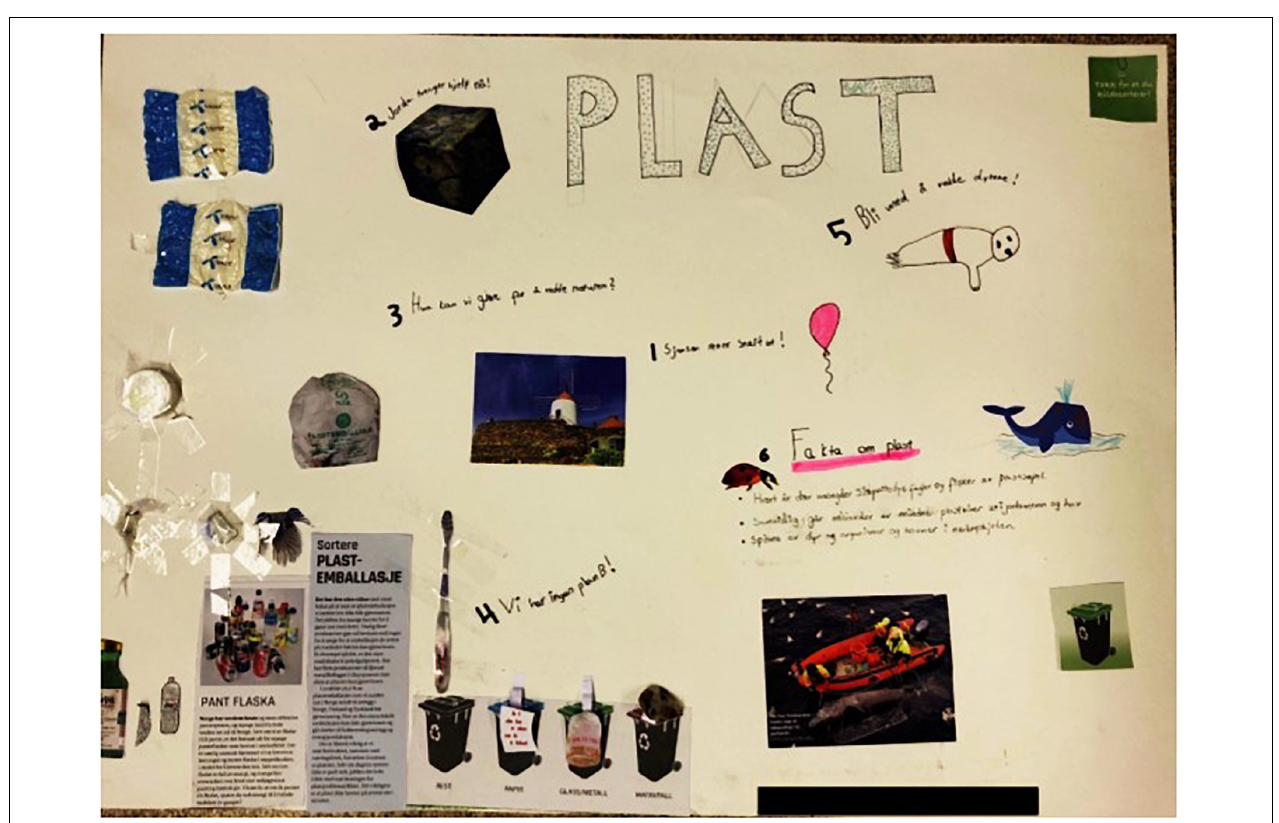
FIGURE 7 | Creative engagement within the frame “school playground” illustrating the importance of recycling and different types of bins (bottom